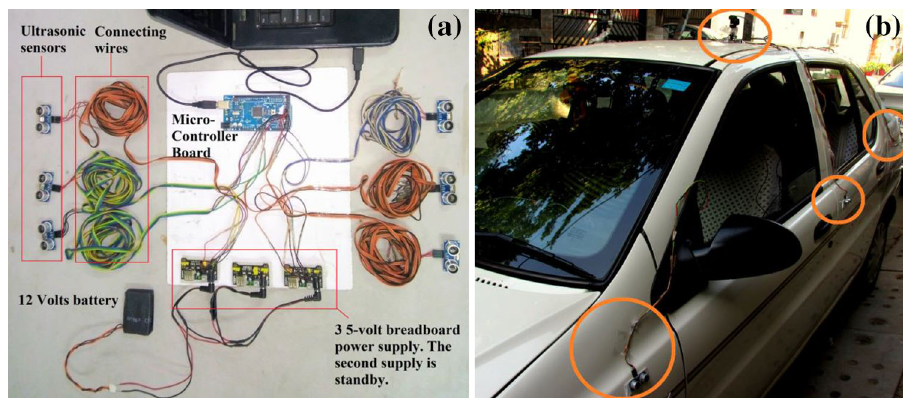
Fig. 1 Microcontroller and sensor setup used for data collection ( a ) and installed sensors on vehicle (